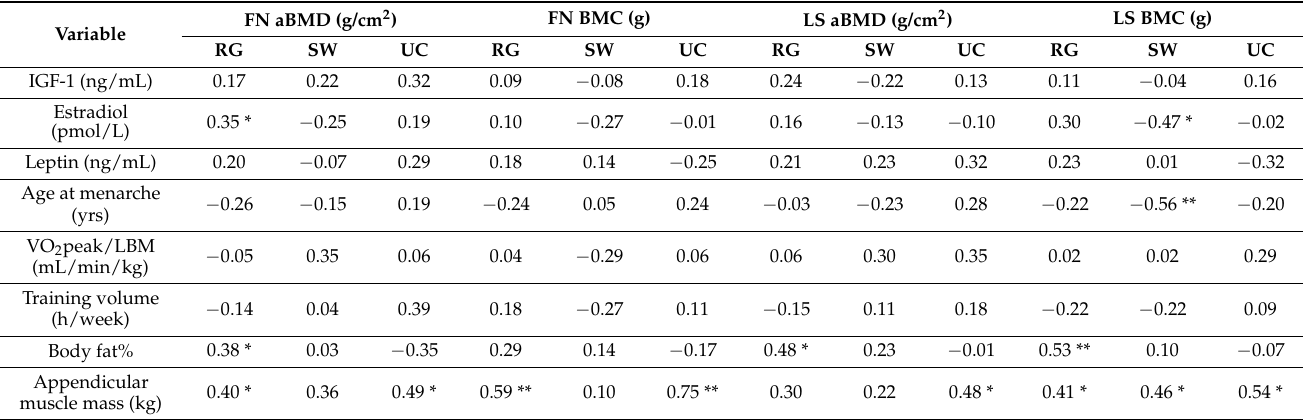
Table 2. Pearson correlation coefficients of bone mineral values with blood biochemical, training and body composi- tional variables.